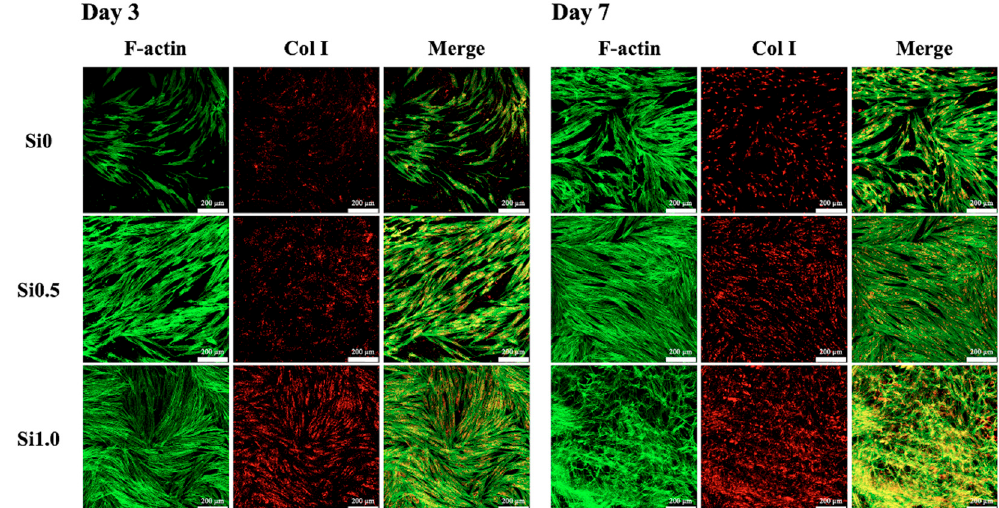
Figure 9. Immunofluorescence staining of Col I expression of hDF cultured on Si-GelMa hydrogels for 3 and 7 days. The scale bar is 200 μ m.